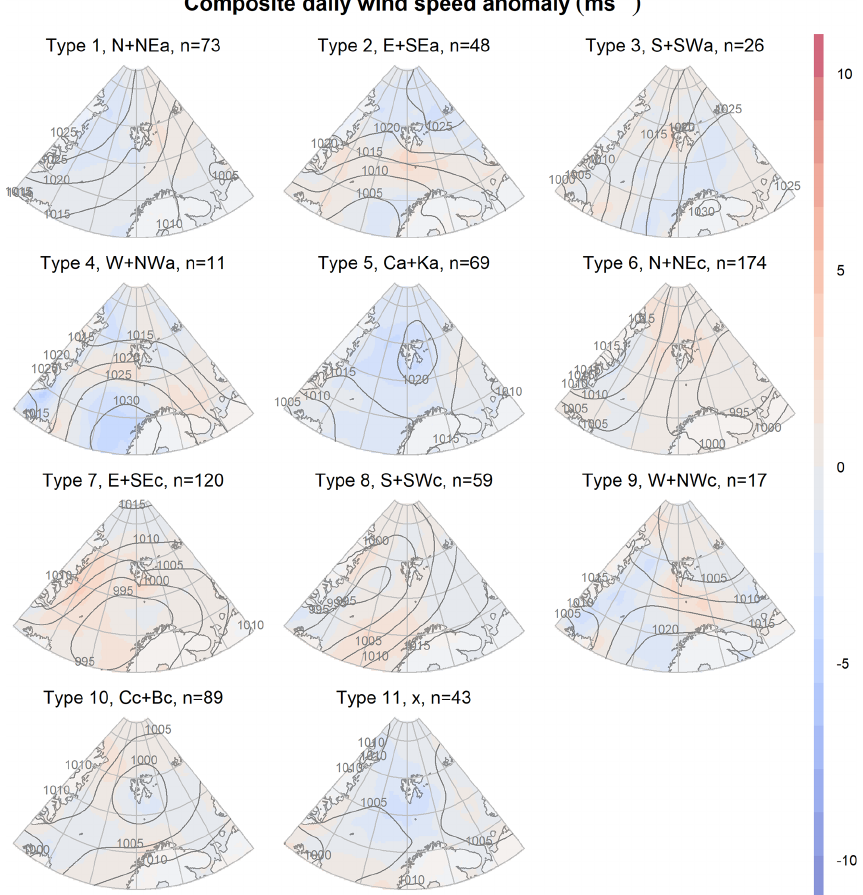
Figure A3. Composite daily mean wind speed anomaly by synoptic type, calculated versus mean daily wind speed conditions (Fig. B3). Composite MSLP isobars by synoptic type are included for